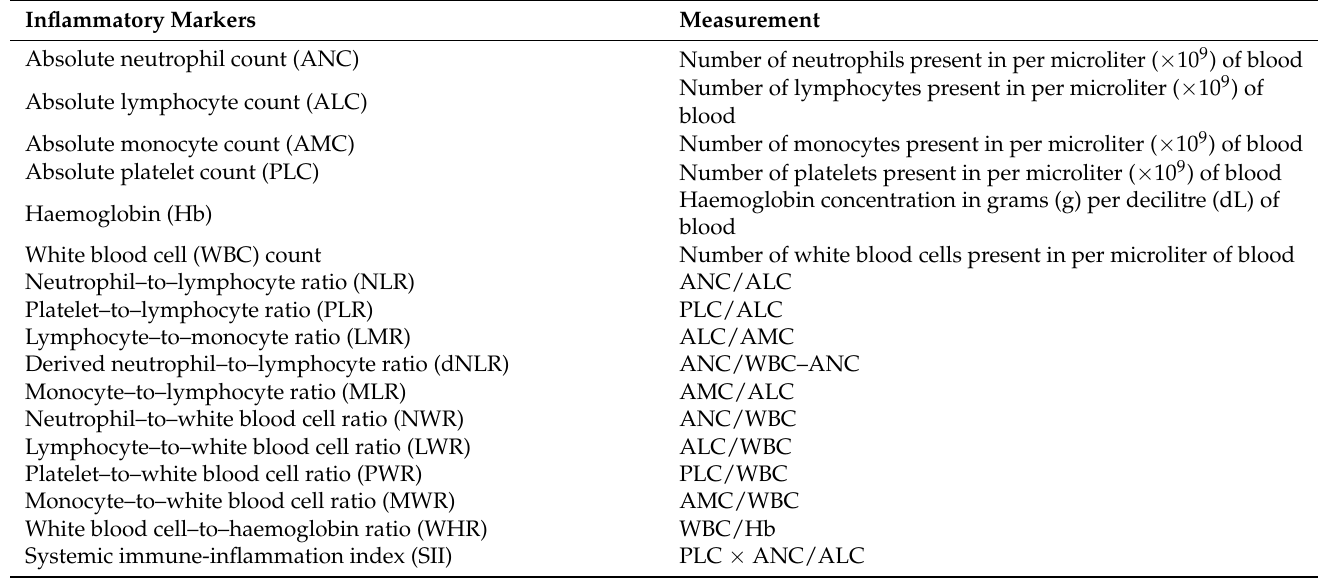
Table 1. Inflammatory markers in peripheral blood included in this